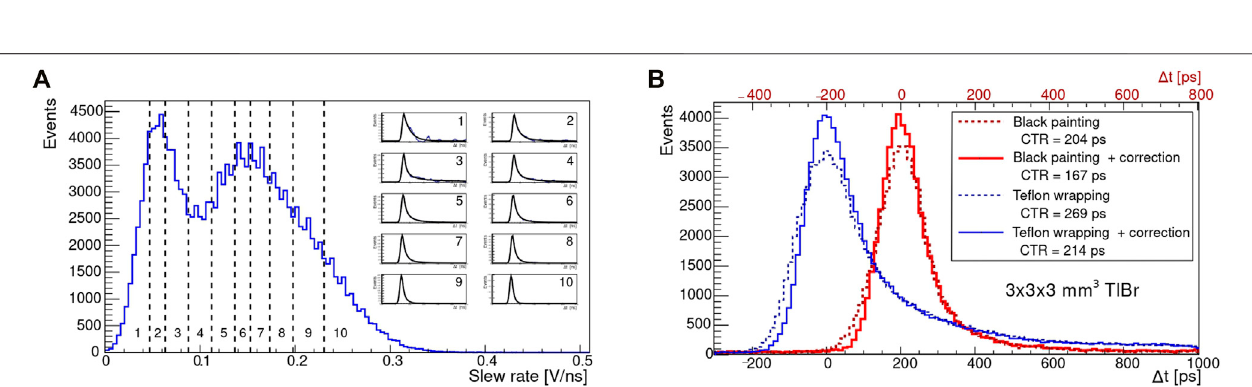
FIGURE 4 | (A) Correction method applied to the case of the Te fl on-wrapped 3 × 3 × 3 mm 3 TlBr crystal. The slew rate distribution is divided into 10 categories containing an equal number of events. For each category, the time delay distribution is interpolated to extract the position of the maximum, which is used to perform the correction. (B) Measured(dashed)andcorrected(solid)timedelaydistributionsfortheblack-painted andTe fl on-wrapped3×3×3 mm 3 TlBrcrystalandextractedCTR values before and after time-walk correction. The curves referring to the black-painted and Te fl on-wrapped crystal are arti fi cially offset by 200 ps for display